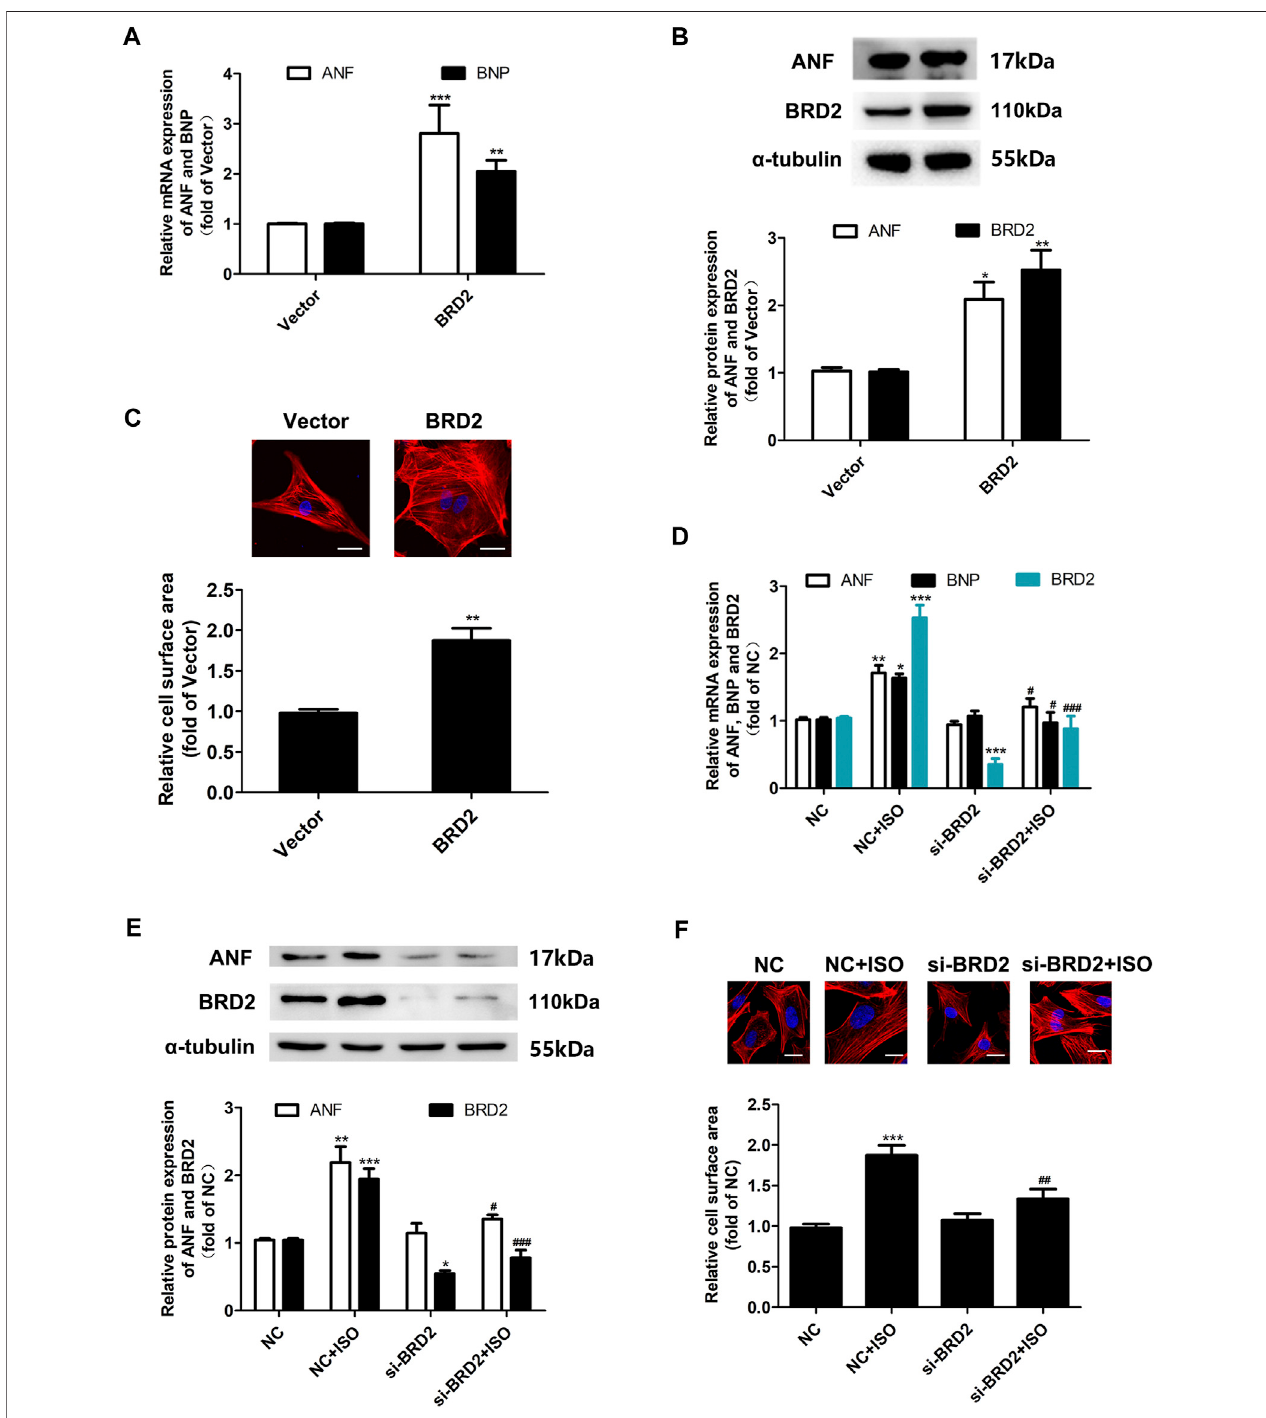
FIGURE 2 | The effects of BRD2 in ISO-induced cardiomyocyte hypertrophy. (A) The mRNA level and (B) protein expression of BRD2, ANF and BNP, and (C) cell surface area measured by rhodamine-phalloidin staining, in cardiomyocytes transfected with BRD2 plasmid or blank vector for 48 h. Scale bar: 20 μ m. (D) The mRNA leveland (E) proteinexpression ofBRD2,ANFandBNP,and (F) cellsurfaceareameasured byrhodamine-phalloidinstaining,incardiomyocytestransfected withsiRNA targeting BRD2 (siBRD2) or negative control (NC) for 48 h, and further incubated with 10 μ M ISO or DMSO for 24 h. The data are presented as mean ± SEM, * p < 0.05, ** p < 0.01, *** p < 0.001 vs. control. # p < 0.05, ## p < 0.01, ### p < 0.001 vs. ISO. n = 4.